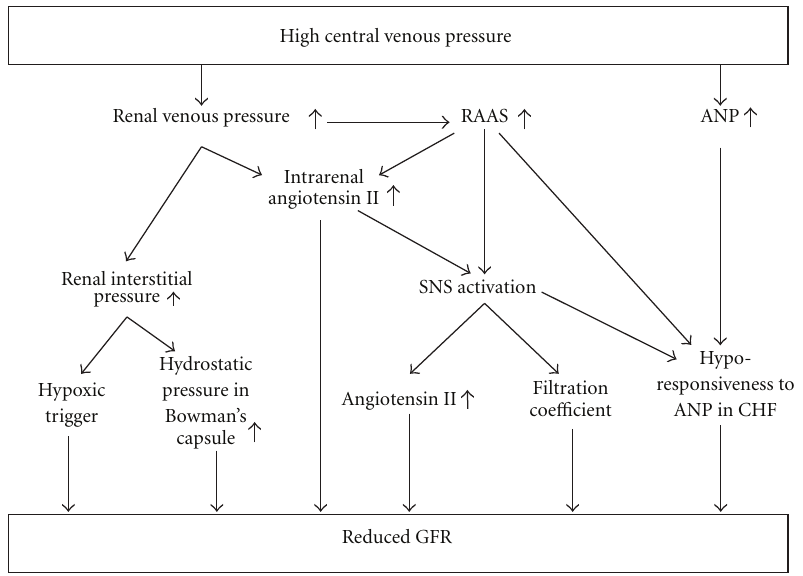
Figure 1: Pathophysiology of the relation between venous congestion and reduced glomerular filtration rate (GFR). Reprinted with modification from Damman et al.